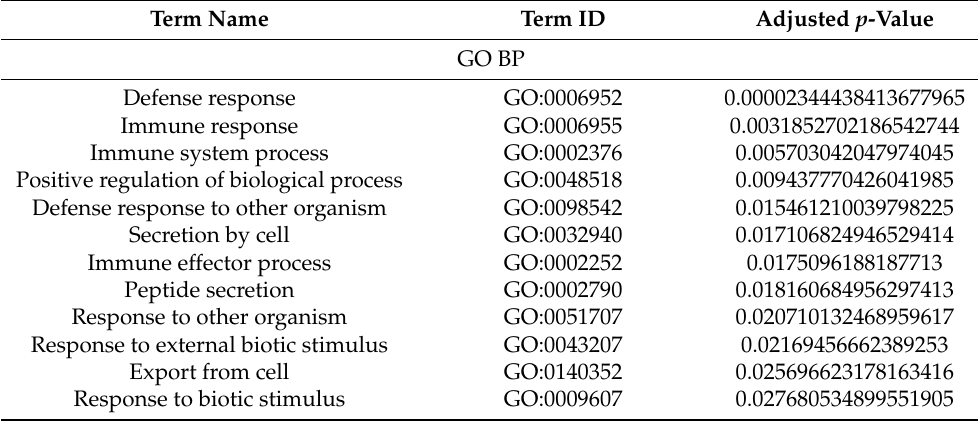
Figure 3. Lollipop chart of the ontology terms (biological process, cellular components, metabolic and signaling pathways) detected during Gene Ontology (GO) and KEGG analysis. Circle size refers to the logarithmic scale of adjusted p -value in enrichment GO analysis. X -axis described the number of DEGs involved in enriched GO terms. Table 1. GO terms and KEGG and REACTOME pathways evaluated in the myometrium treated with an EMF at 50 Hz for 2